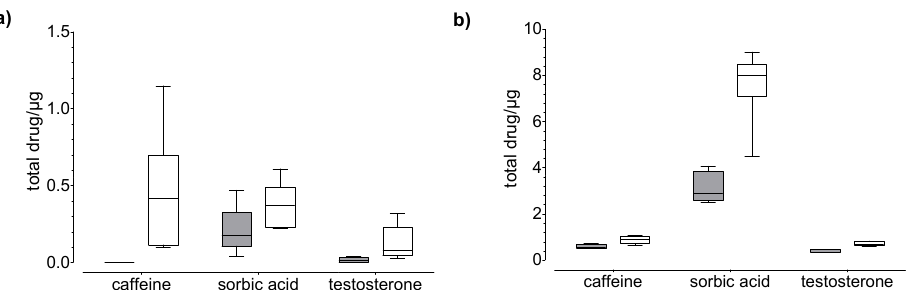
Figure 3. Results of the drug ( a ) permeation through and ( b ) penetration into nail (grey) and hoof (white) membrane after 24 h of exposure to caffeine, sorbic acid, and testosterone (donor: 20 µg). Box plot with median, minimum, maximum, and the 0.25 and 0.75 quartiles. n = 6.